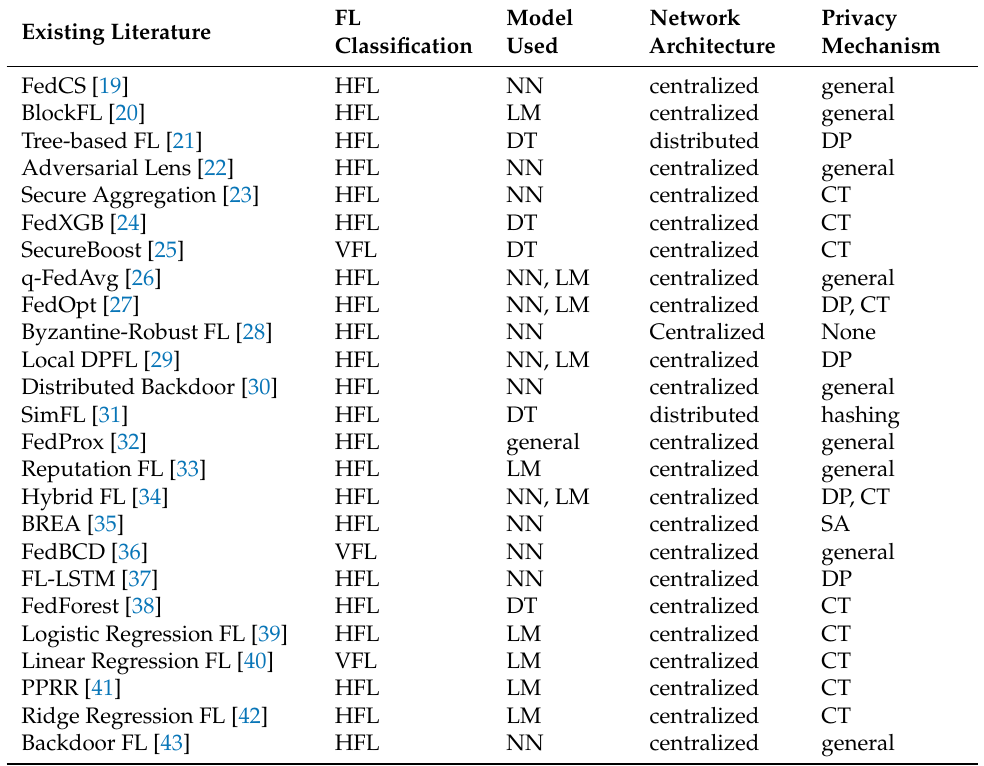
Table 1. Summary of existing literature on privacy and security concerns in FL. Here, NN denotes Neural Network, LM denotes Linear Model, DT denotes Decision Tree, SA denotes Secure Aggregation, DP denotes Differential Privacy, and CT denotes Cryptographic Technique.